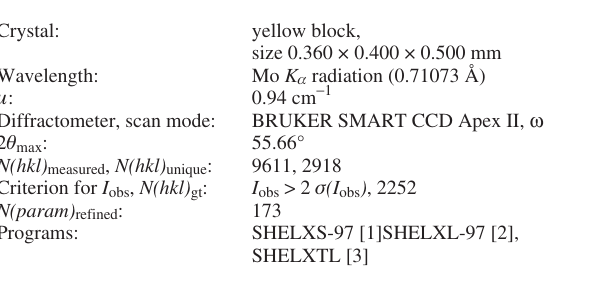
Table 1. Data collection and handling.